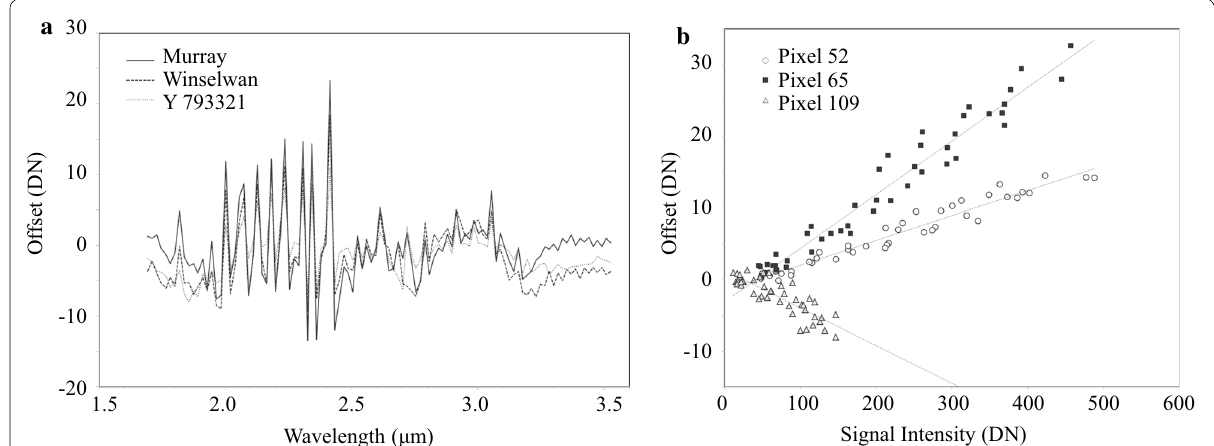
Fig. 3 Systematic offset values calculated from Eq. (4). a Offset value spectra over all the pixels for Murray, Jbilet Winselwan, and Y-793321 meteorite samples. b Relationship between the signal intensity and the offset value for three select pixels, using data for all the meteorite samples except